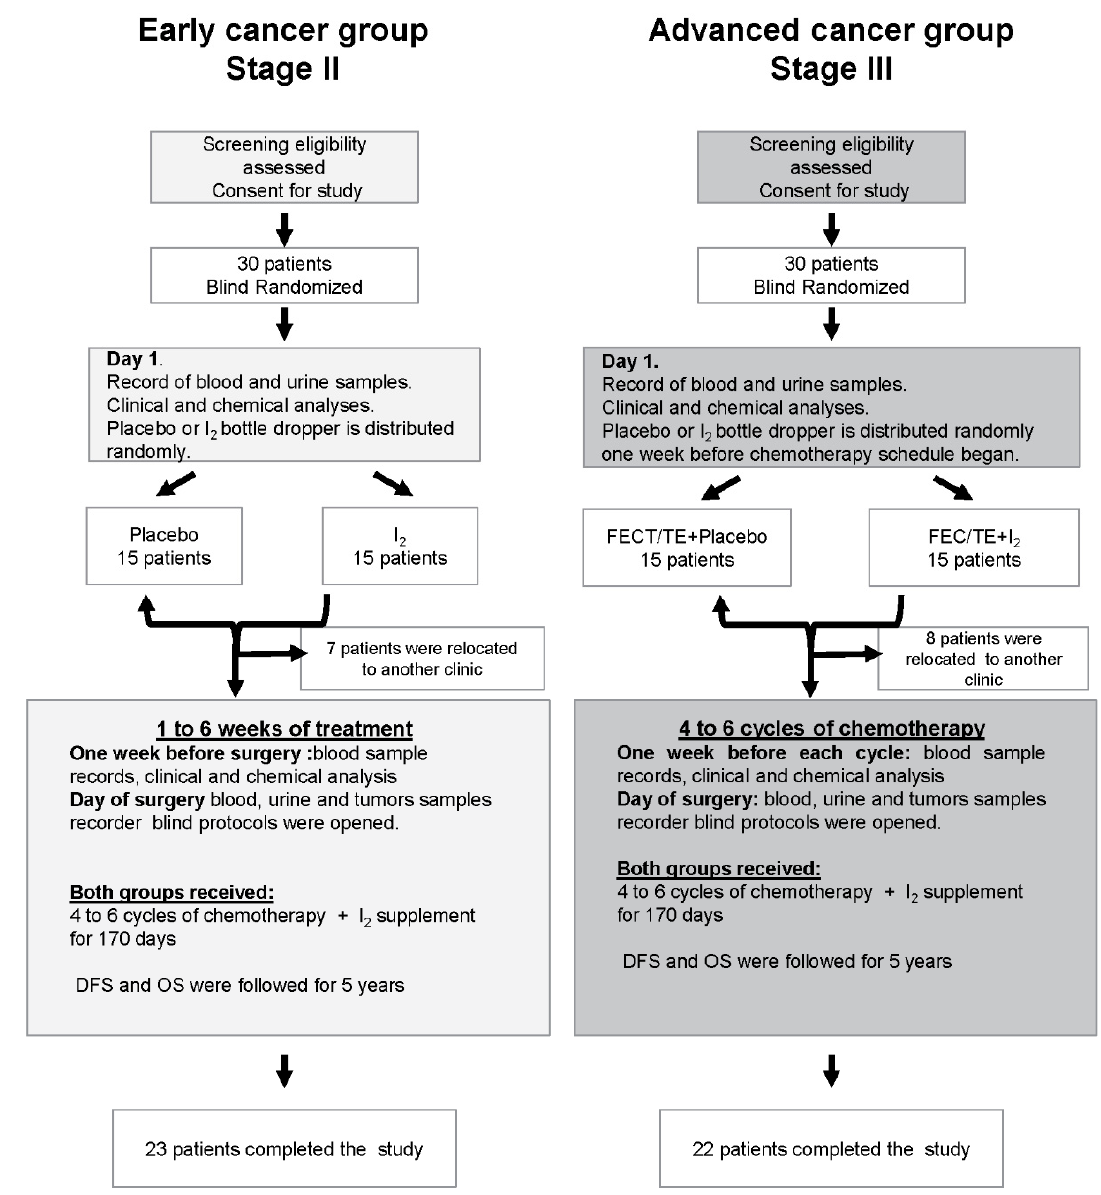
Figure 1. Flow diagram of study design.